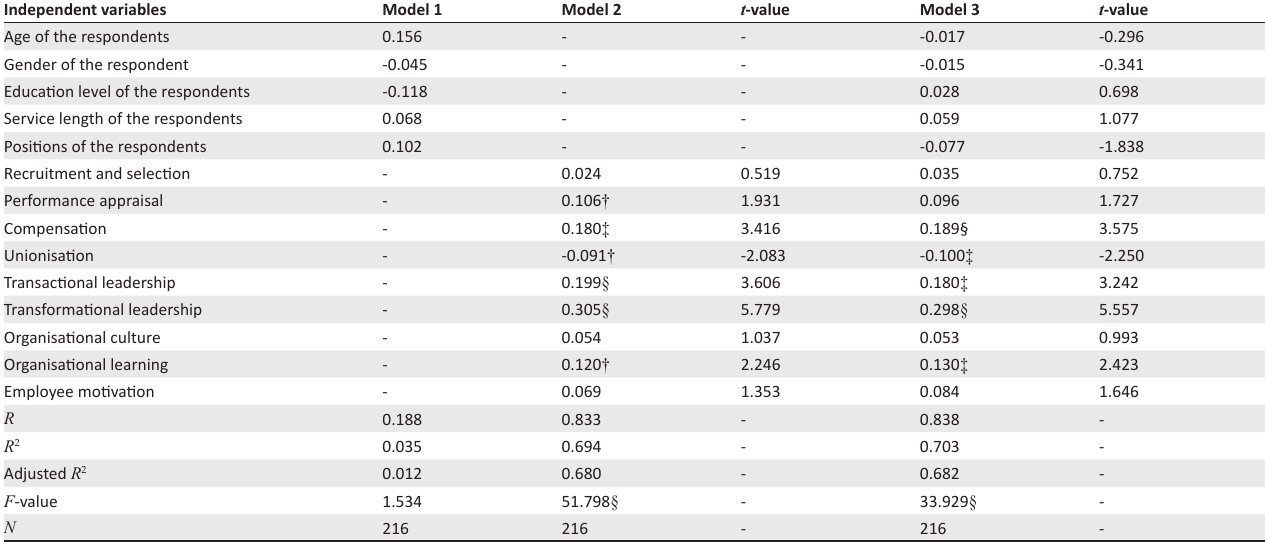
TABLE 2: Regression model of demographic and independent variables with organisational change. Independent